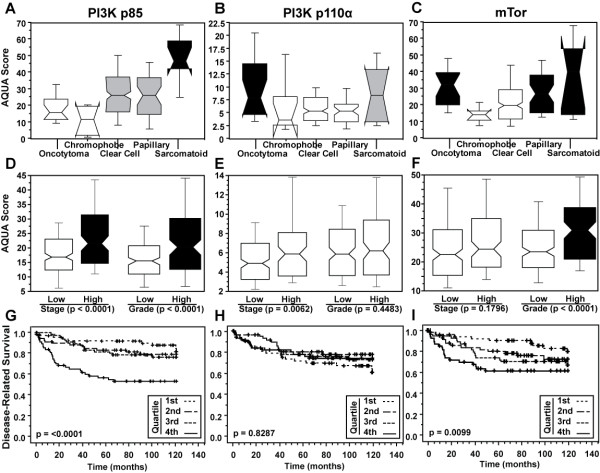
Associations between marker expression and clinical/pathological variables. (A) Associations between target expression (p85, p110α and mTOR) and histologic subtype. Expression of all three targets was higher in sarcomatoid tumors. (B) Associations between target expression and tumor stage and Fuhrman grade. p85 and mTOR were associated with high grade and p85 with high stage. p110α levels were not associated with stage or grade. (C) Kaplan-Meier survival curves of quartiles of AQUA scores for the three targets. High levels of both p85 and mTOR were associated with decreased survival.